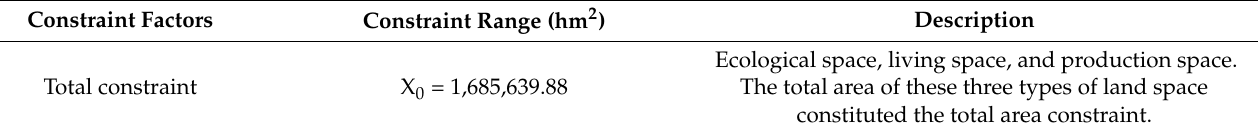
Table 5. Multiobjective function